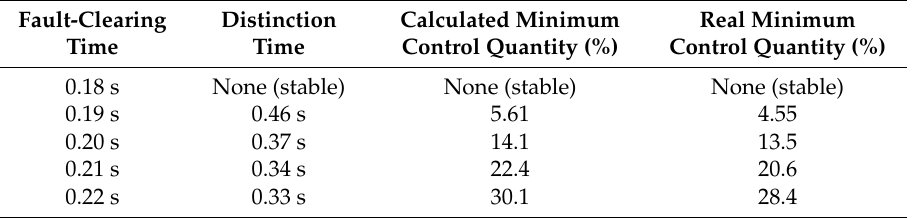
Table 4. Calculated minimum control compare to the real minimum control.